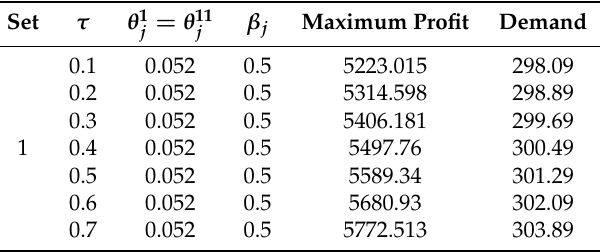
Table 14. Sensitivity Analysis (w.r.t τ ).